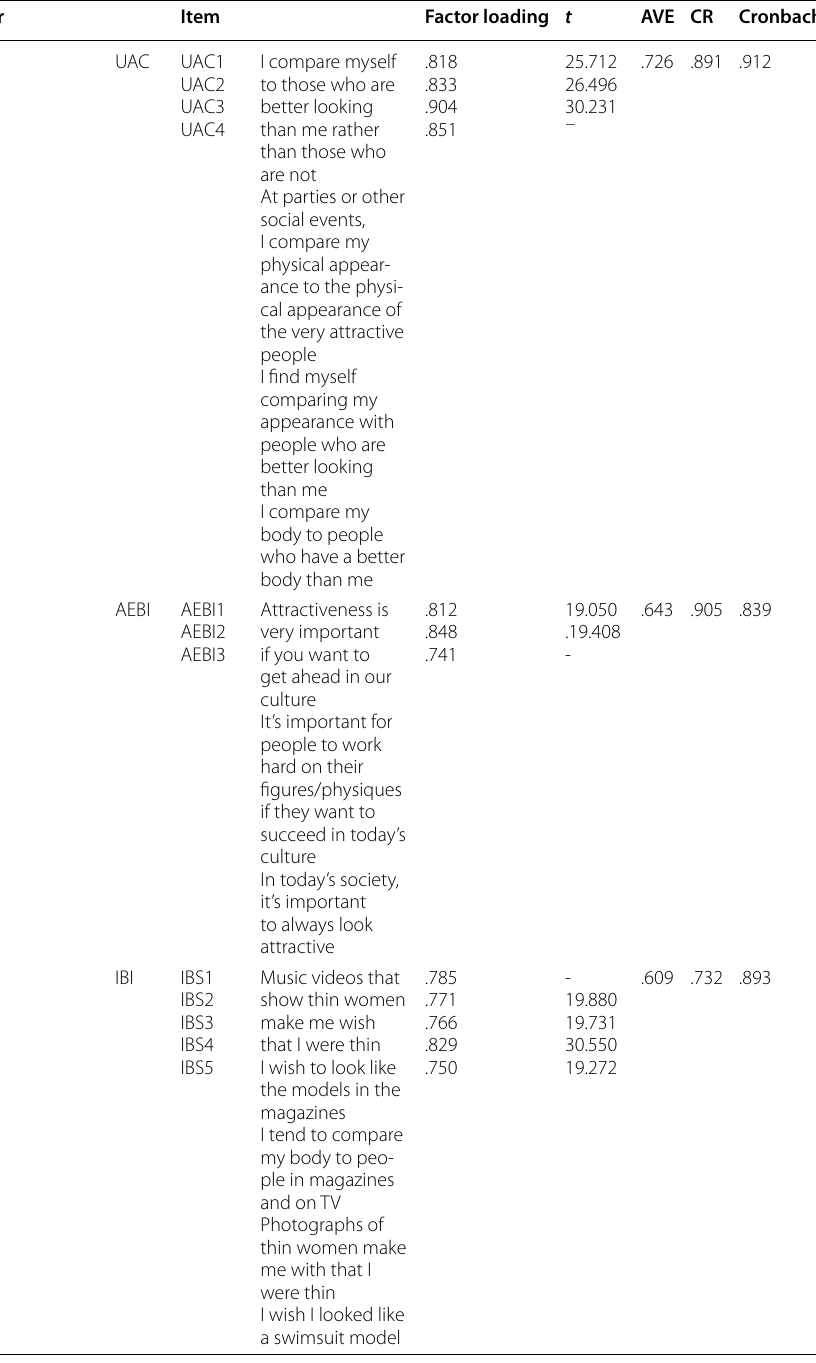
Table 4 Results of confirmatory factor analysis Factor Item Factor loading t AVE CR 1 st